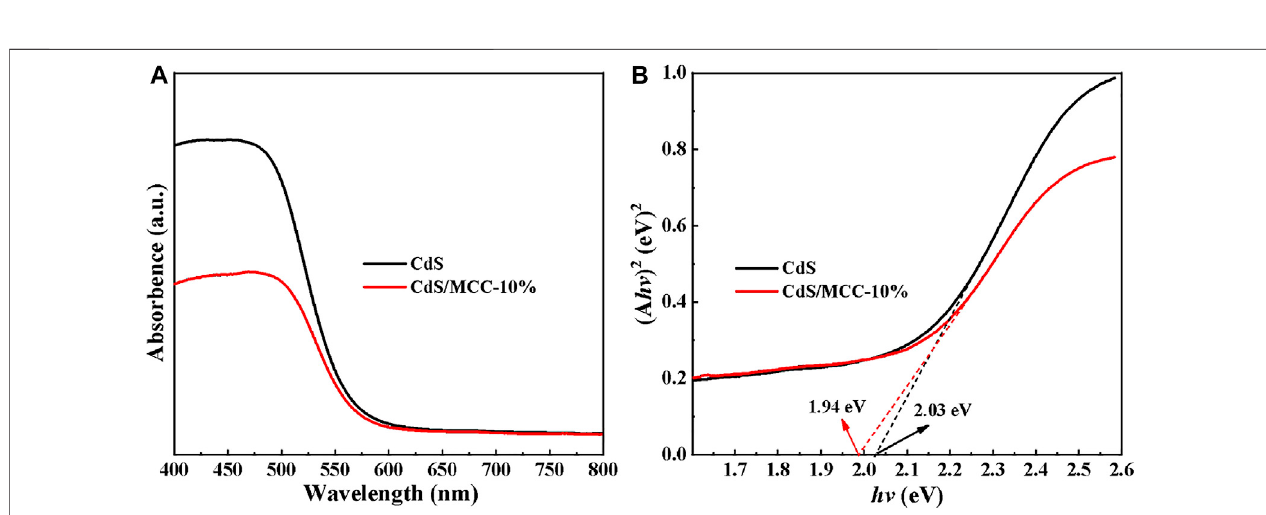
FIGURE 4 | (A) UV – Vis DRS results and (B) Plots of (A hv ) 2 vs. hv to determine the E g values of pure CdS and